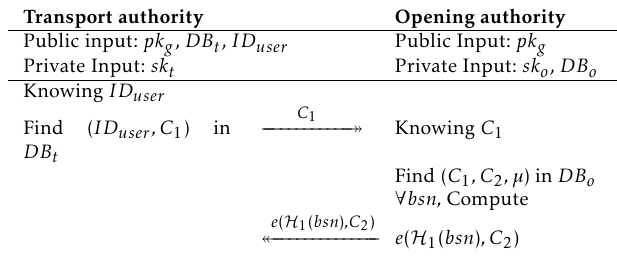
Table 4. Protocol for blacklisting a